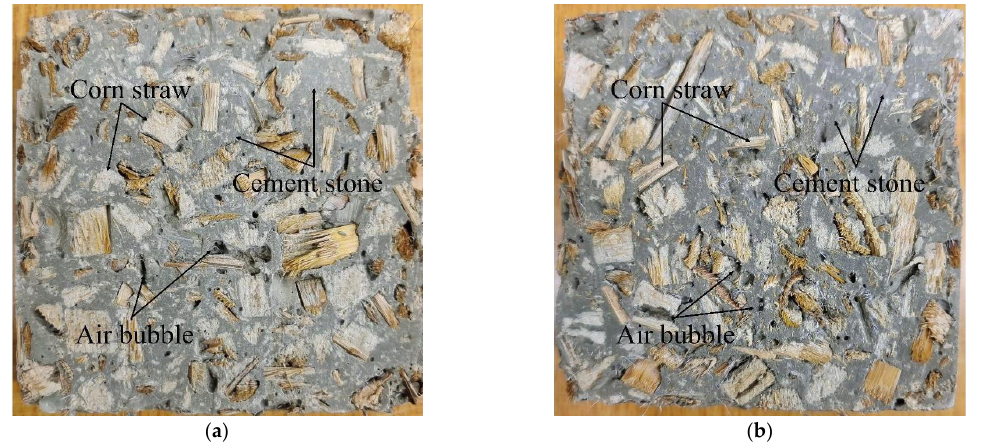
Figure 10. CSCC 100 × 100 × 100 mm 3 slice: ( a ) CSCC-7, ( b )